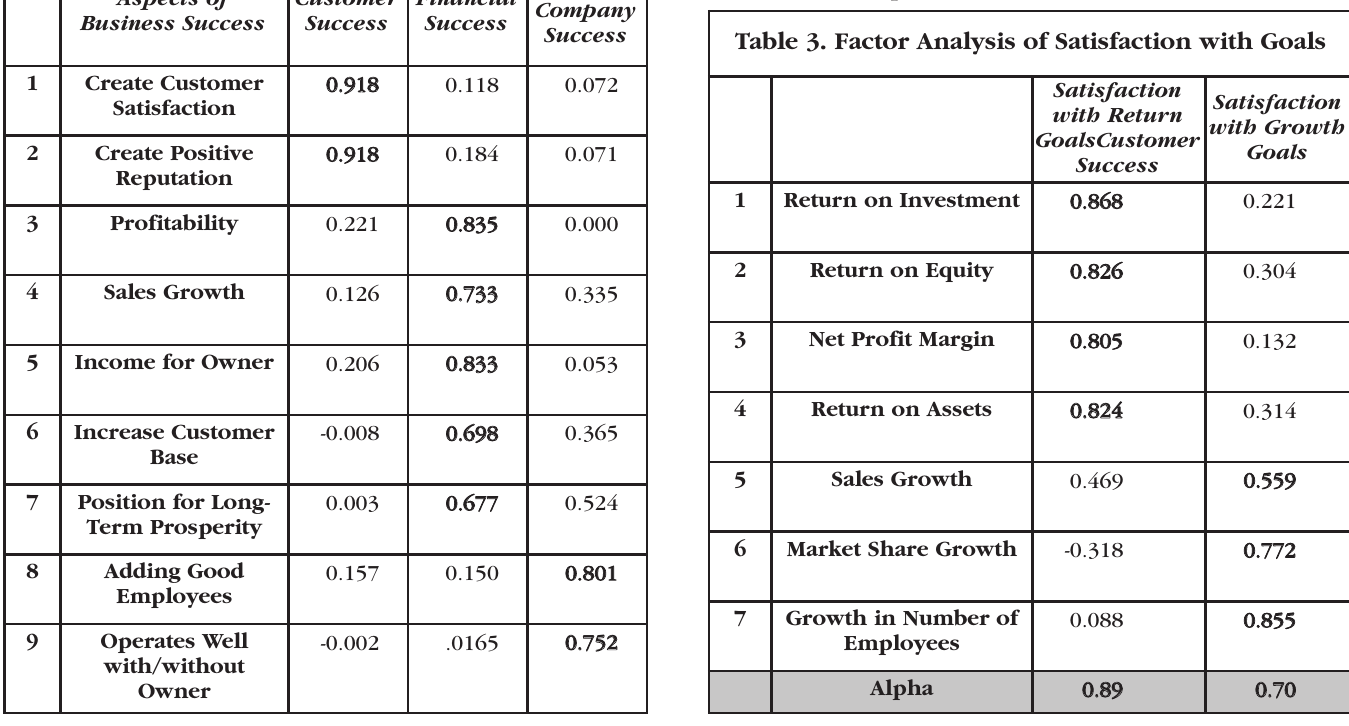
Table 3. Factor Analysis of Satisfaction with Goals